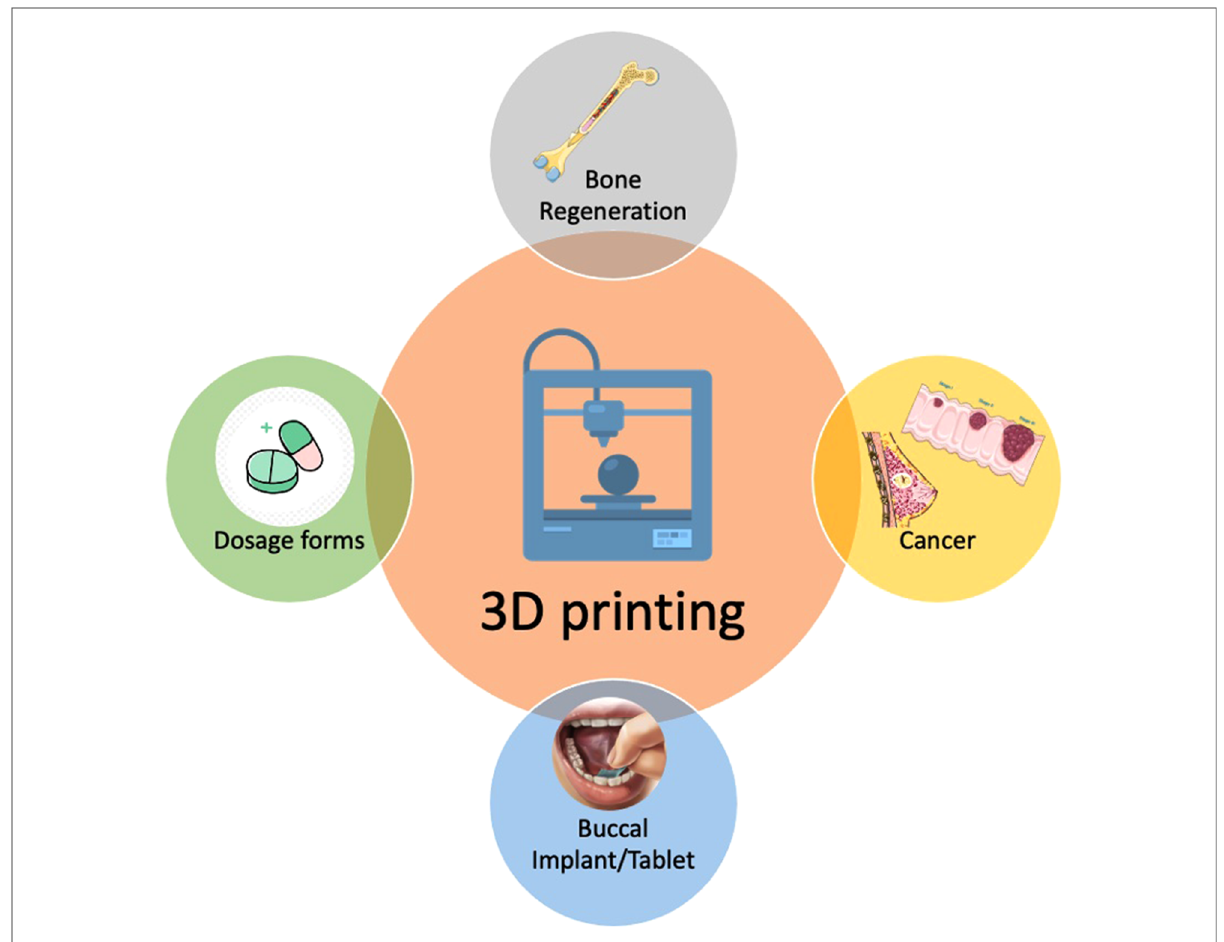
FIGURE 1 Cartoon showing the applications of 3D printing in disease